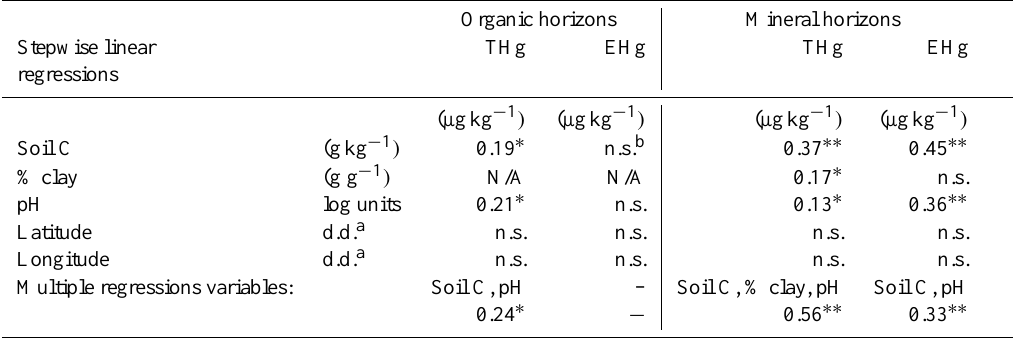
Table 2. Displayed are R 2 values for stepwise and multiple linear regressions of site location and select soil properties with total Hg (THg) and exchangeable Hg (EHg) concentrations for organic and mineral horizons.